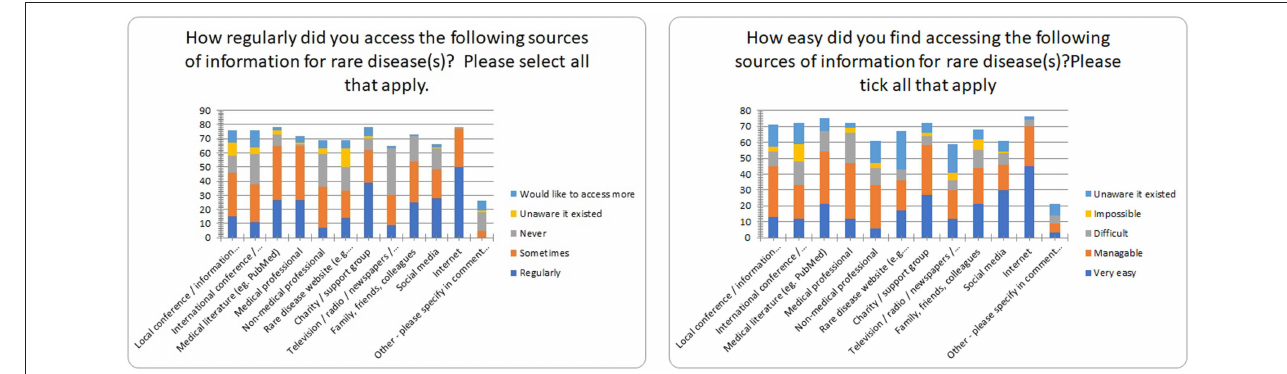
FIGURE 4 | Regularity and ease of access of information sources for rare disease.